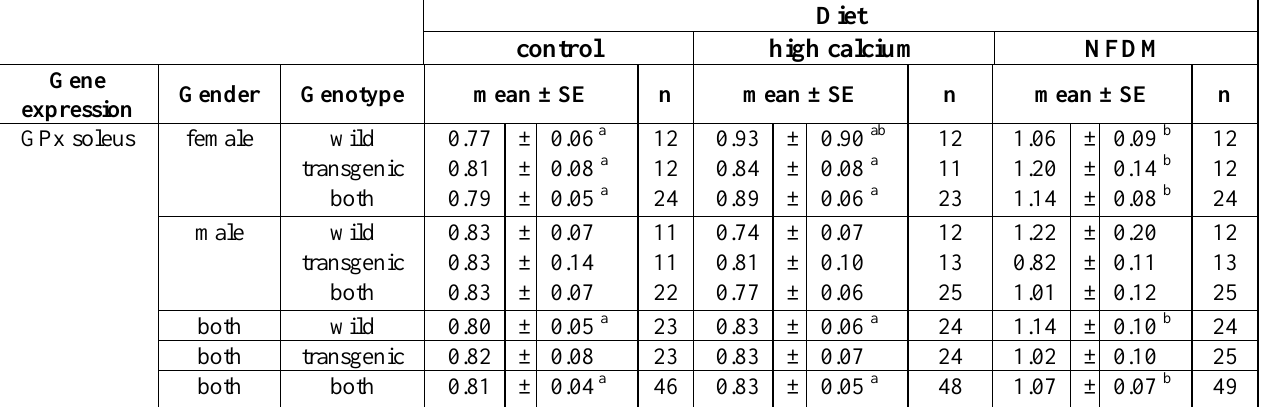
Table 4. Glutathione Peroxidase (GPx) (soleus muscle) and Superoxide Dismutase 3 (SOD3) gene expression (soleus muscle and liver) and liver SOD enzyme activity of aP2-agouti transgenic and wild-type mice fed control, high calcium or NFDM diets (all three age groups combined). Gene expression data are normalized to 18S expression, enzyme activity to protein content. Values are expressed as mean ± SE. Non-matching superscripts denote significant differences between diet groups, p < 0.05. Diet control high calcium NFDM Gene